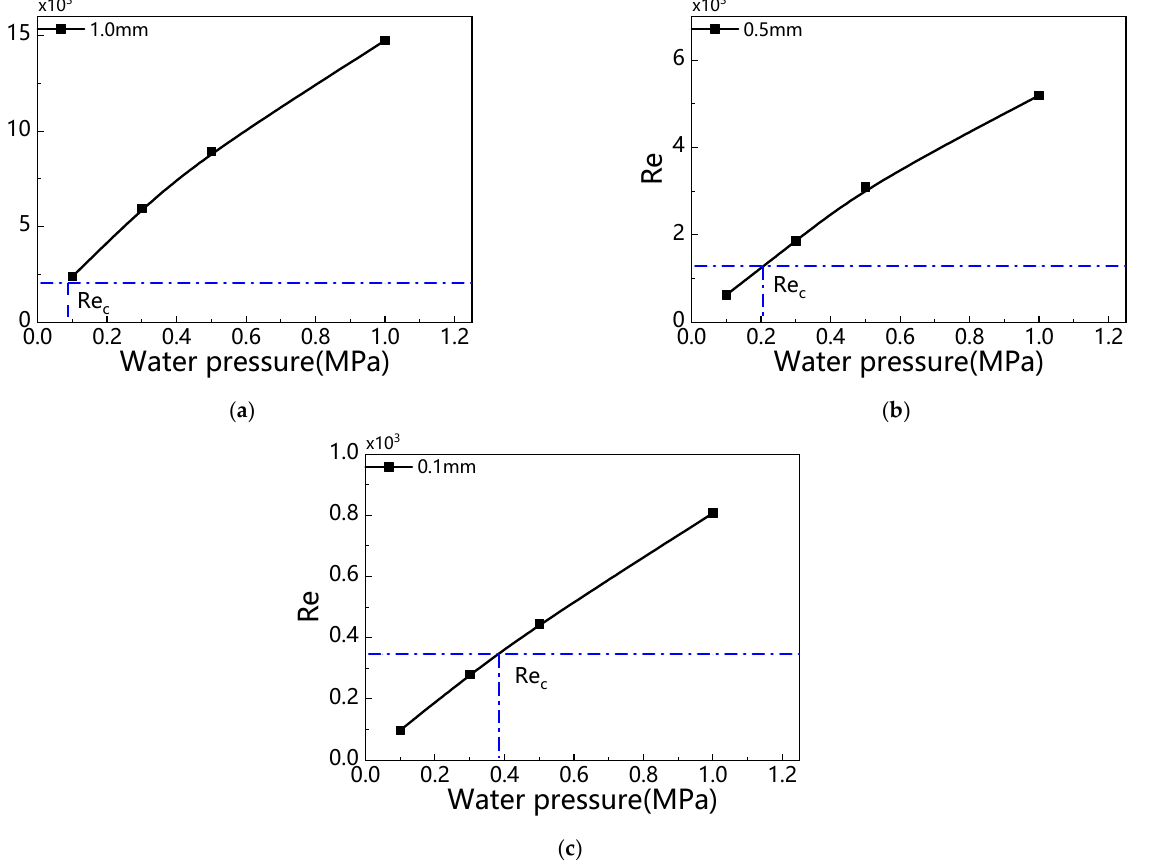
Figure 21. Variation curve of Reynolds number and water pressure: ( a ) aperture is 1 mm, ( b ) aperture is 0.5 mm, ( c ) aperture is 0.1 mm.